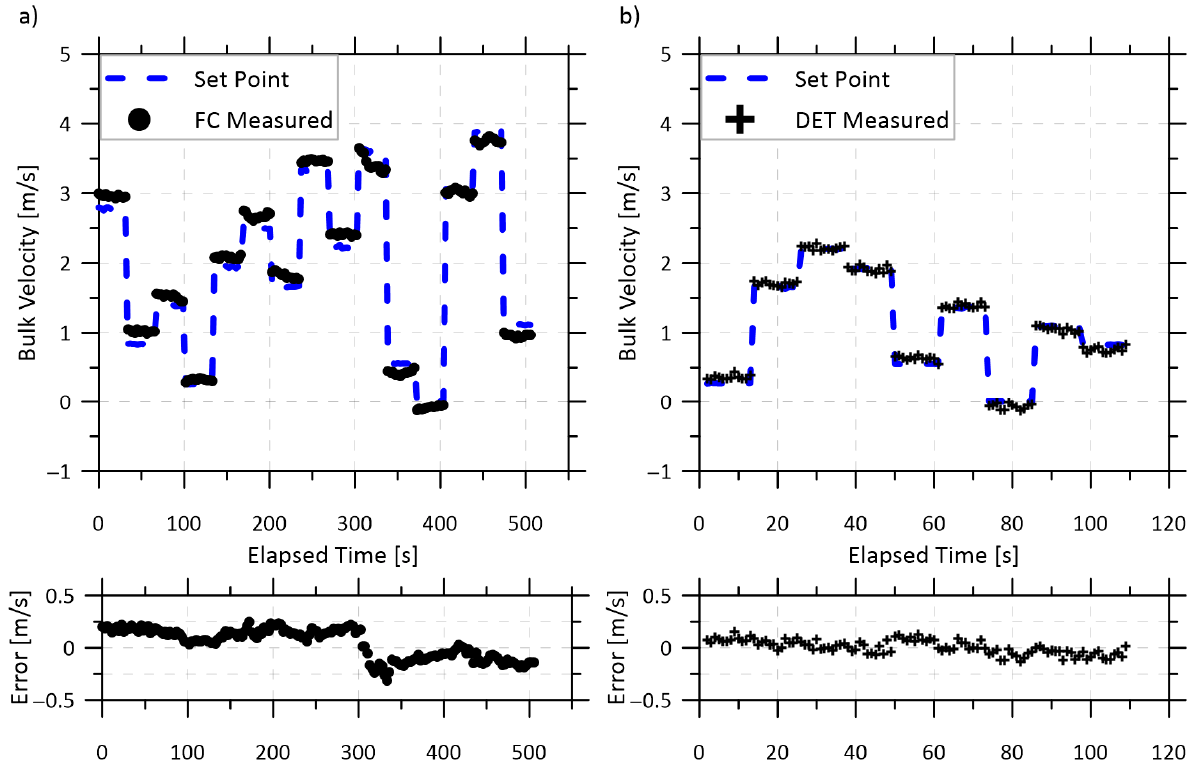
Figure 4. Time-resolved velocity of pure methane compared to set points as reported by mass flow controllers for ( a ) the FC configuration and ( b ) the DET configuration. The lower plots show the measurement error for their respective sequences.